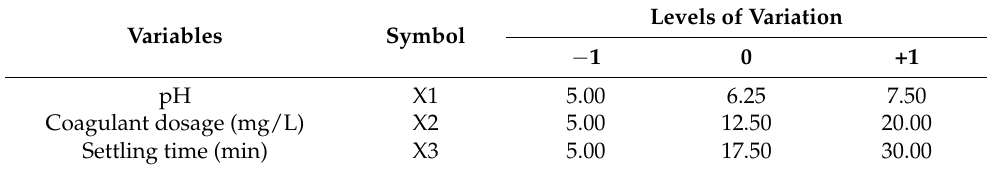
Table 3. Experimental ranges of factors examined using Box–Behnken design for